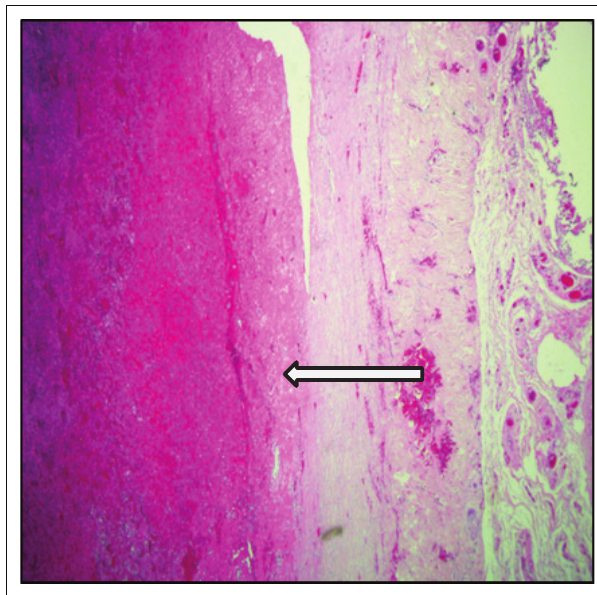
FIGURE 4: Haematoxylin and eosin (H&E) photomicrograph at 20× magnification of the fibrous pericardium showing organising fibrin deposition.